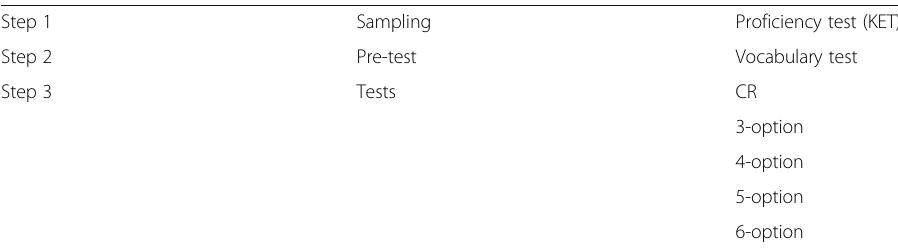
Table 1 Design of the study